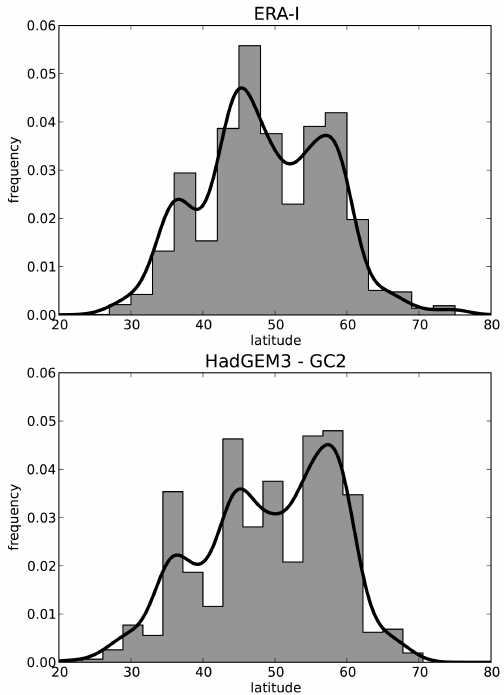
Figure 11. Normalized frequency distribution of DJF jet latitude de- fined as the maximum 850hPa wind over the North Atlantic 60 ◦ W– 0 ◦ E (following Woollings et al., 2010) for ERA-I 1979–2012 and the final 20 years of HadGEM3-GC2 CLIM